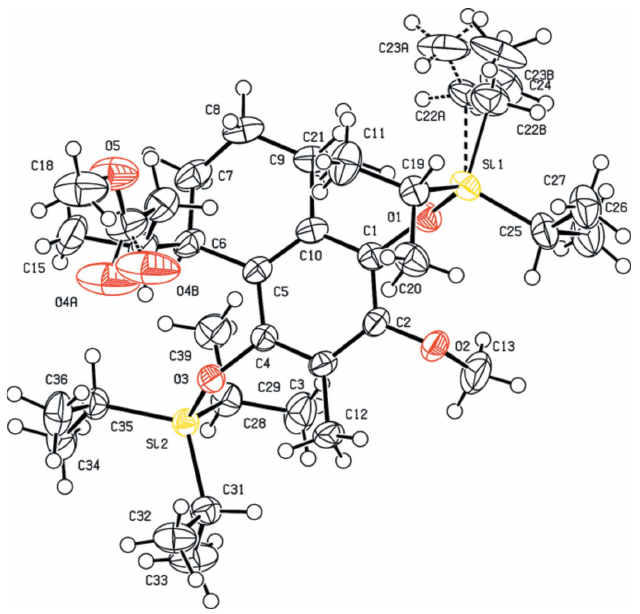
Figure 1 Molecular structure of ( 2 ) with displacement ellipsoids drawn at the 50% probability level. Disorder is indicated by dashed lines (minor occupancy